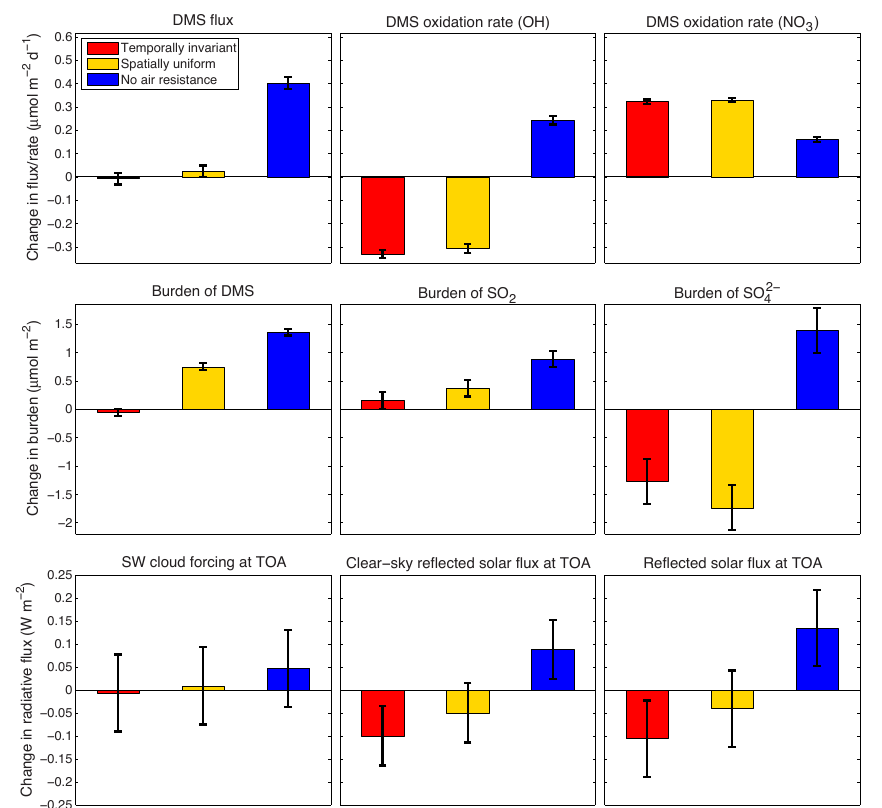
Figure 9. Absolute differences in global-mean flux, oxidation rates, sulfur burdens, and radiation between the control run and model runs with seasonally invariant (red) or spatially uniform (yellow) DMS concentration, as well as the L10 & N00 model experiment (blue). Fluxes and oxidation rates of DMS are shown in the upper panels. The global-mean DMS flux includes terrestrial sources to ensure mass balance. The only sink for DMS is oxidation to SO 2 , which is shown for both oxidation pathways (oxidation by OH and NO 3 radicals). Absolute changes in the atmospheric sulfur burdens of DMS, SO 2 , and SO 2 − are shown in the middle panels. Bottom panels show absolute changes 4 in cloud forcing, clear-sky reflected and total reflected shortwave flux. Total reflected flux is the sum of cloud and clear-sky reflected flux. To derive the error estimates, all treatments (control, temporally invariant, spatially uniform, and no air-side resistance) were pooled after their separate means were removed; error bars are ± 2 standard deviations of the pooled data ( n = 12). Statistical significance is determined by comparing the mean differences among the model runs with the corresponding error